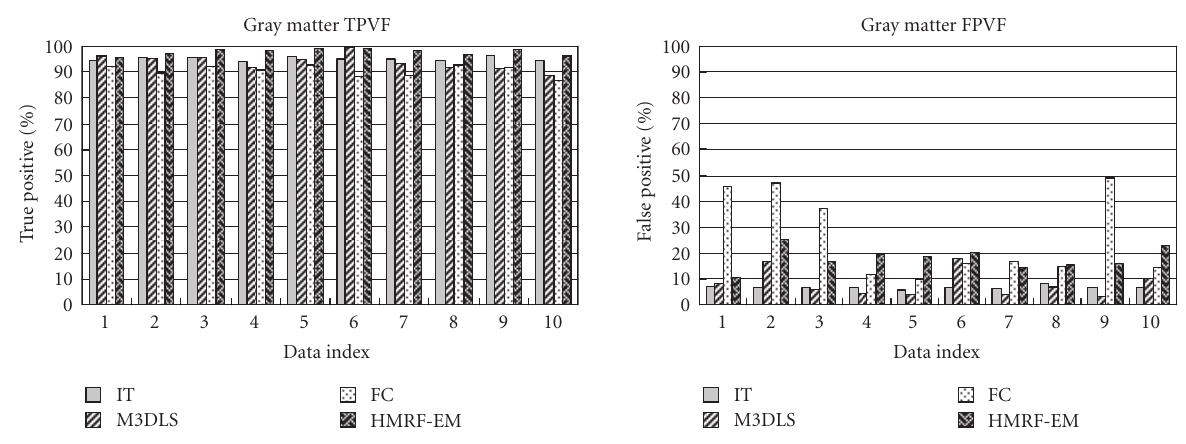
Figure 8: TPVF and FPVF errors for segmentation of GM.